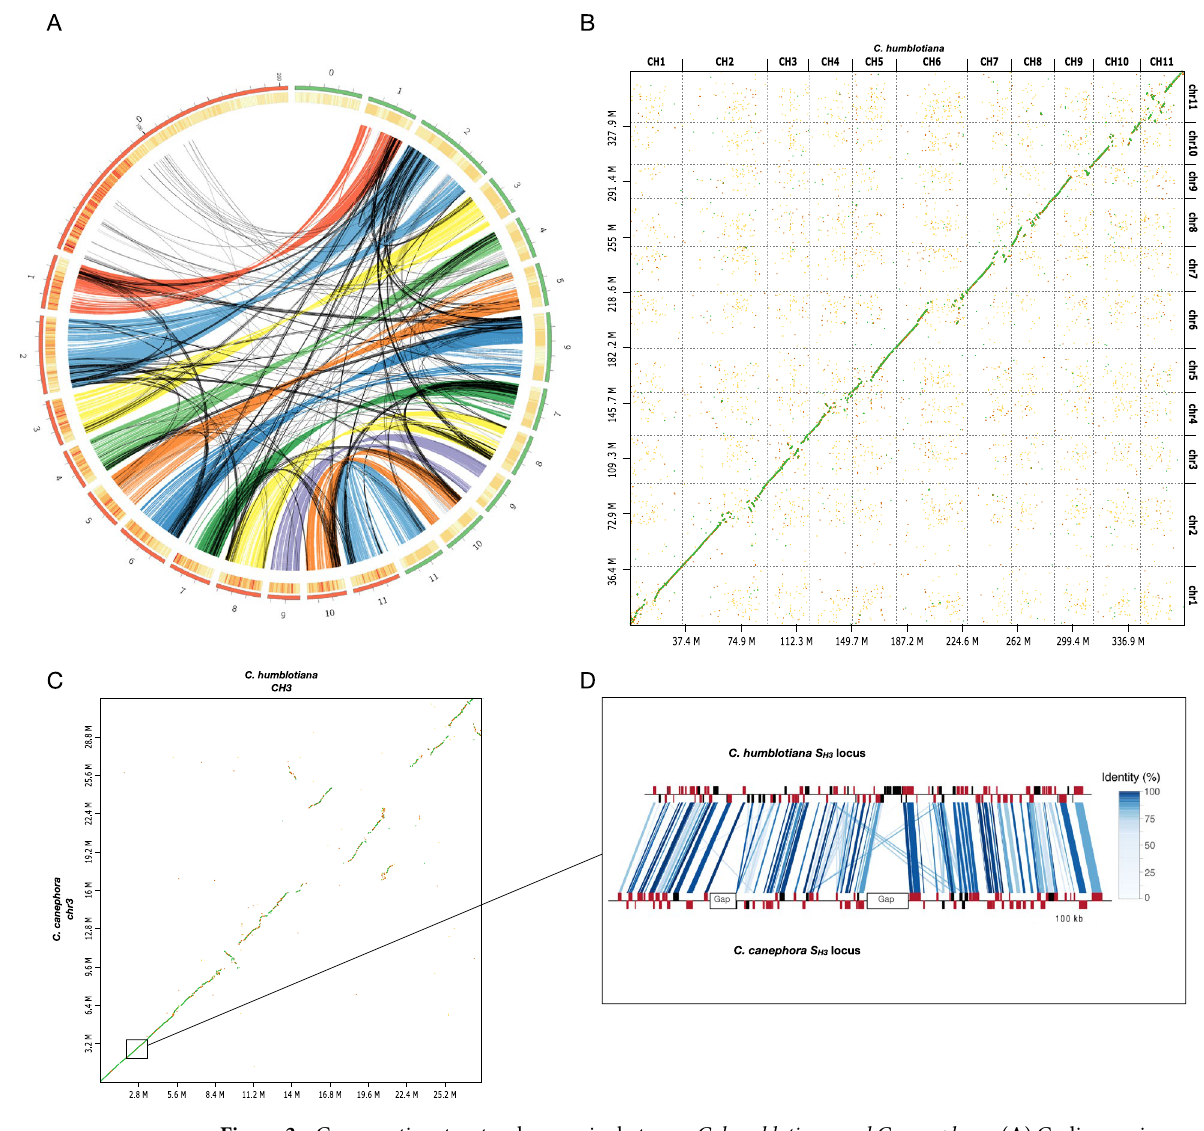
Figure 3. Comparative structural genomics between C. humblotiana and C. canephora. ( A ) Coding-region- based synteny between C. canephora (red) and C. humblotiana (green). For graphical purpose only, non- anchored contigs/scaffolds were merged into a single chromosome-zero (1000 N interspersed). ( B ) Whole genome dot plot between the C. humblotiana pseudo-chromosomes (horizontal sequence) and the C. canephora published pseudo-chromosomes (vertical sequence). ( C ) Dot plot between the pseudo chromosomes 3 of C. humblotiana and C. canephora. ( D ) Graphical representation of the 727 Kb region from C. humblotiana (upper line), and the 820 Kb region from C. canephora (lower line) at the S H3 locus, showing their annotated genes. Red boxes correspond to genes with one orthologous gene found in the compared segment, while black boxes account for unpaired or duplicated genes. White boxes represent a stretch of Ns found on the C. canephora genome. Colored lines linking both genomes represent the percentage of protein identity found in a pairwise comparison between genes.